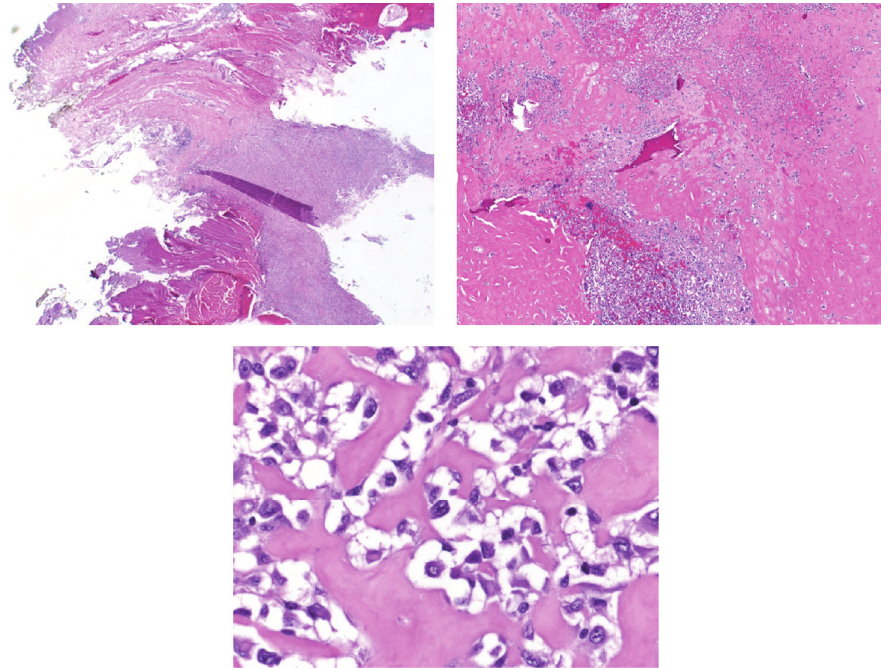
Figure 5: Showing low, intermediate, and high resolution histopathology slide prominently featuring rhabdoid-appearing cells producing osteoid which is pathognomonic for